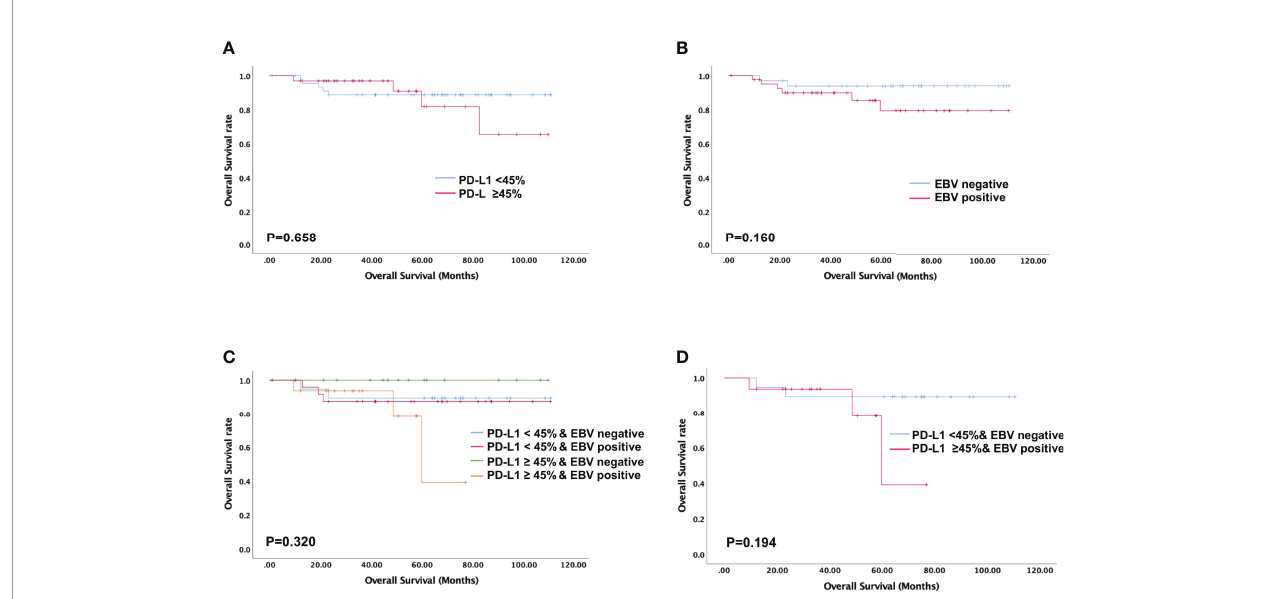
FIGURE 4 | Evaluation of overall survival using the Kaplan-Meier survival analysis. No overall survival difference is noted in NPC patients strati fi ed according to PD-L1 expression, EBV status, and their combination. (A) Overall survival based on tumoral PD-L1 expression alone; (B) Overall survival based on EBV status alone; (C, D) Overall survival based on PD-L1 expression levels and EBV